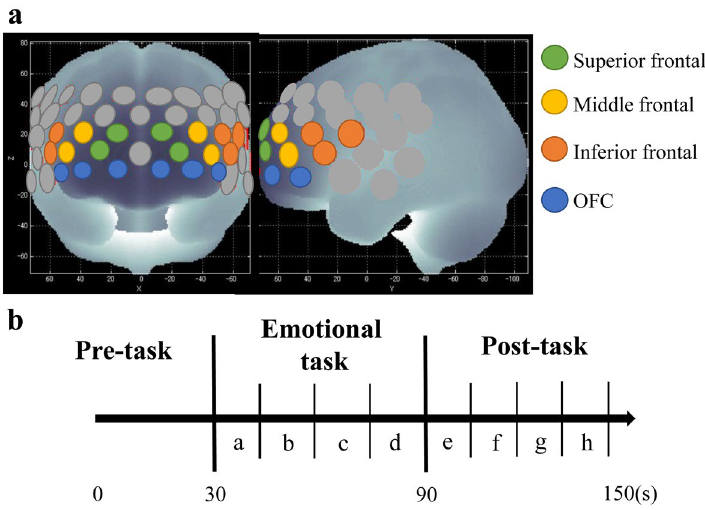
Figure 1. NIRS brain areas of measurement and periods of the emotional Stroop task. ( a ) Anatomical area measured in the NIRS. ( b ) Eight periods (a–h) within the